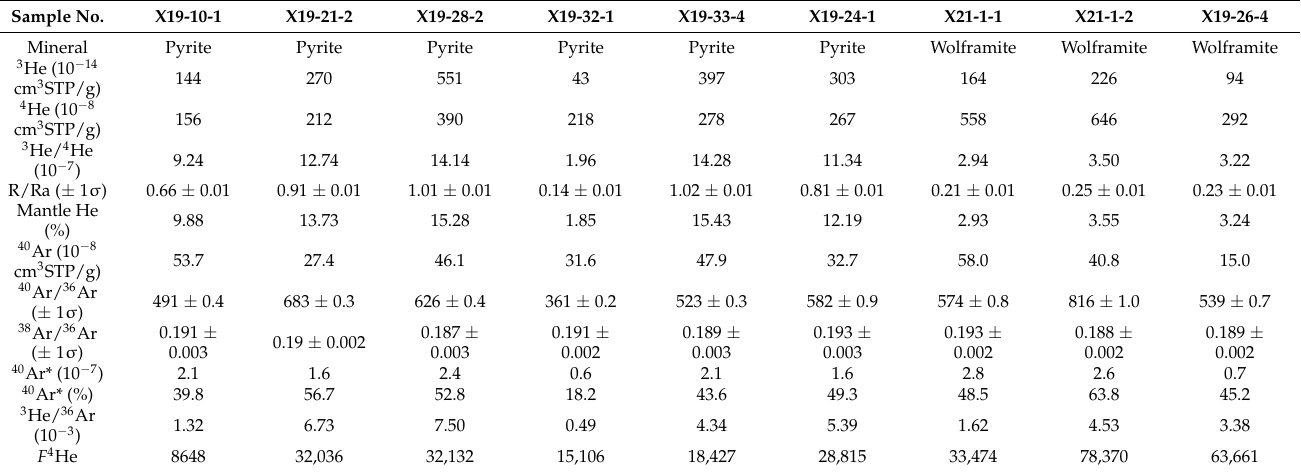
Table 2. He-Ar isotopic compositions of fluid inclusions trapped in pyrite and wolframite from the Xingluokeng W-Mo polymetallic